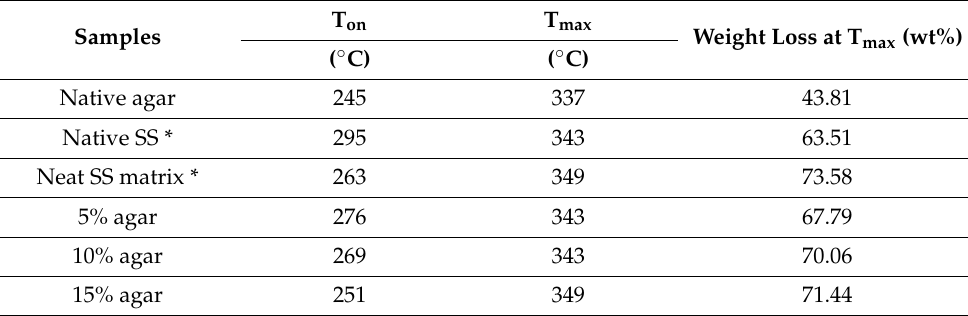
Figure 4. TGA and DTG of TPSS blended with different ratios of agar. Table 2. TGA results of